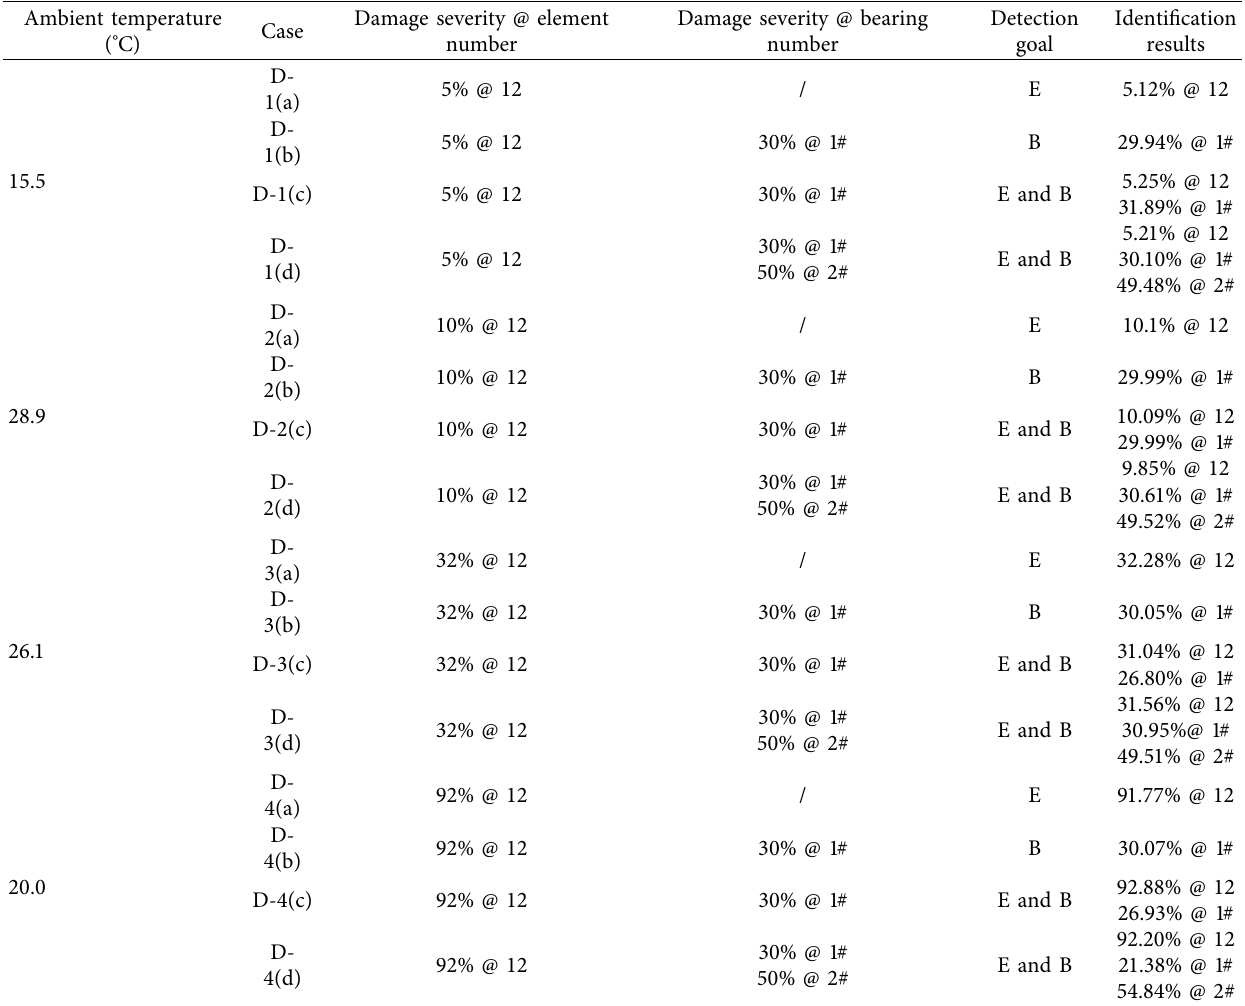
Table 4: Damage cases and identification results of the I-40